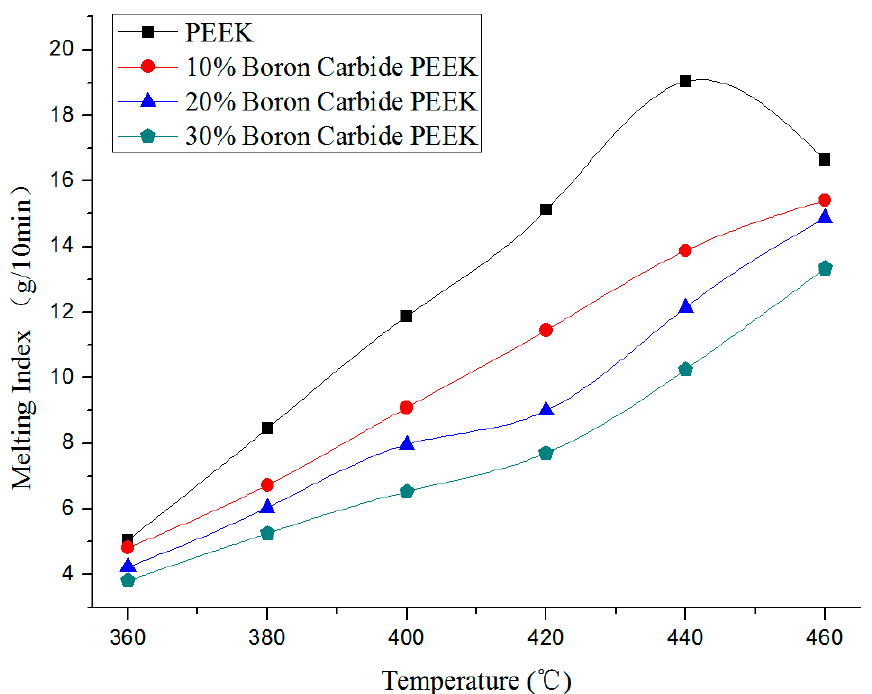
Figure 3. Change in melting index of boron carbide PEEK composites as a function of temperatures (5000 g).